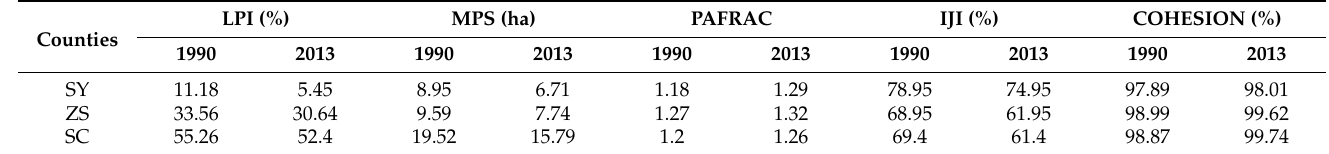
Table 4. Landscape indices of Shaoyang (SY), Zhushan (ZS), and Shicheng (SC) counties.